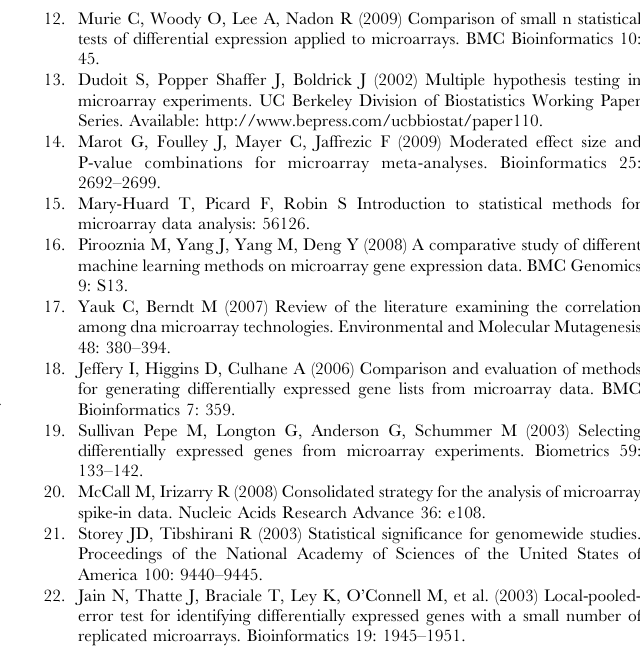
Table S1 Example of binary matrix. For a given test, the genes identified as differentially expressed (‘‘1’’) and not differentially expressed (‘‘0’’) at a given p-value threshold are reported in the binary matrix.